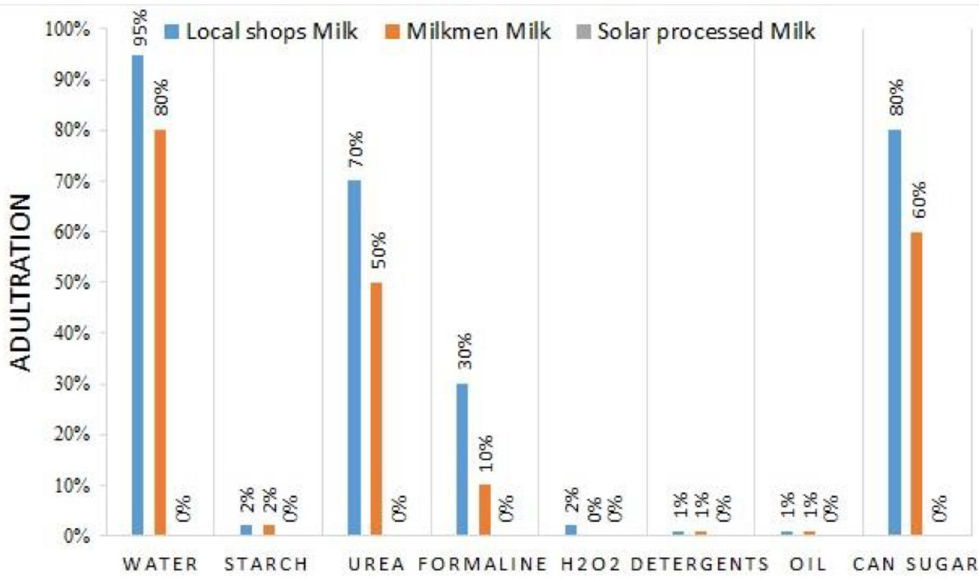
Figure 4. Milk adulteration in local market milk and solar-processed